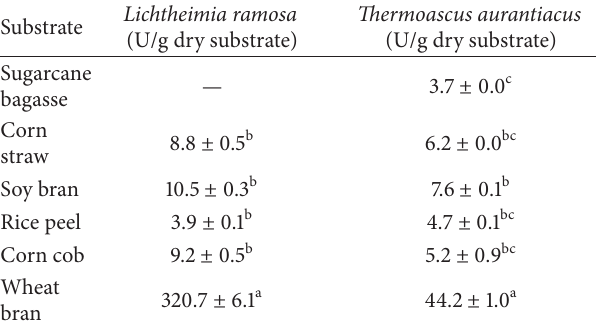
Table 1: Amylase production by solid-state fermentation in several agroindustrial residues after 120 hours of cultivation with 75% mois- ture at pH 5.0. Average production with different letters indicates significant differences ( 𝑃 < 0.0001) according to Tukey